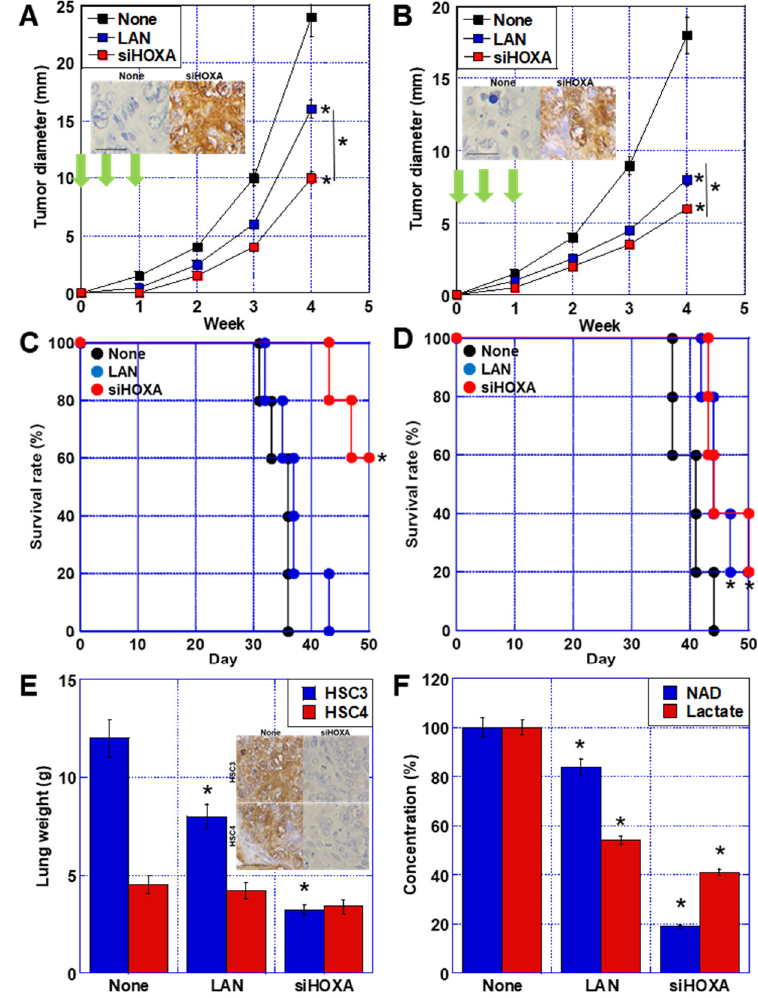
Figure 6. Effect of targeting HOXA11-AS on tumor growth and metastasis of OSCC cells. ( A , B ) Subcutaneous HSC3 or HSC4 tumors were treated with liposome-encapsulated siHOXA11-AS (20 pmol/mouse, i.p.) or lanthanide (0.5 μ mol/kg body weight, i.p.) on Day 1, 3, and 7. (Inset) Immunostaining of NQO2. Scale bar, 50 μ m. ( C , D ) Survival of mice in “no treatment” control (None), lanthanide, and siHOXA11-AS groups. ( E ) In the lung metastasis model, mice were treated with siHOXA11-AS or lanthanide on Day 1, 3, and 7. (Inset) Immunostaining of NQO2. Scale bar, 50 μ m. ( F ) Intratumor concentration of NAD and lactate in the subcutaneous tumors. Error bars indicate SD calculated using Student’s t -test for five mice. Asterisk, p < 0.05. OSCC, oral squamous cell carcinoma; siHOXA, small interfering RNA for HOXA11-AS ; LAN, lanthanide; NAD, nicotinamide adenine dinucleotide.